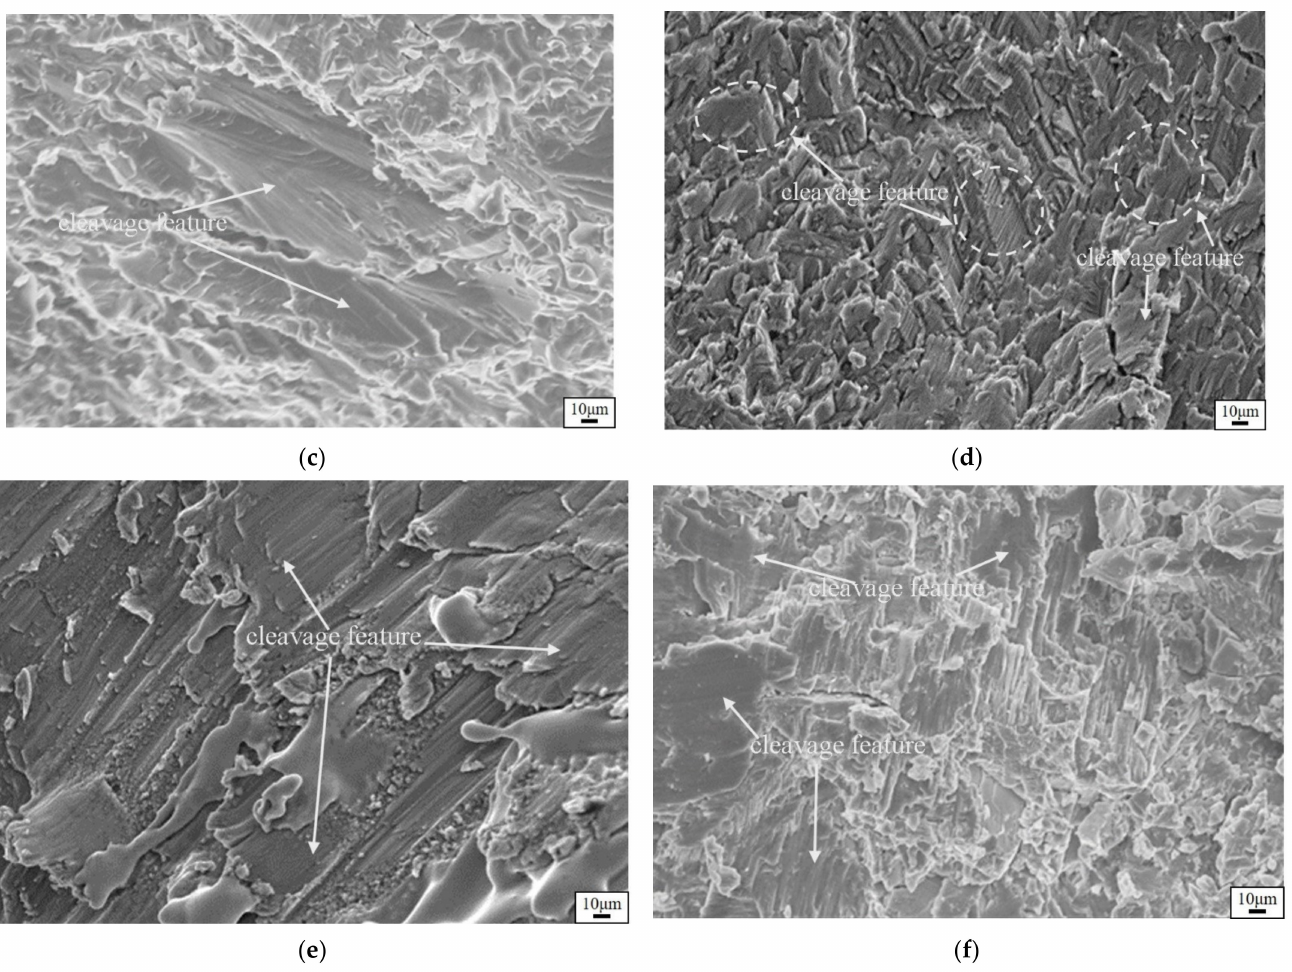
Figure 6. Fracture morphologies of: ( a ) TiAl 46 Cu 3 specimens deformed at 1 × 10 − 3 s − 1 , ( b ) 4 × 10 − 3 s − 1 ; ( c ) TiAl 46 Cu 4 specimens deformed at 1 × 10 − 3 s − 1 , ( d ) 4 × 10 − 3 s − 1 ; ( e ) TiAl 46 Cu 5 specimens deformed at 1 × 10 − 3 s − 1 , ( f ) 4 × 10 − 3 s − 1